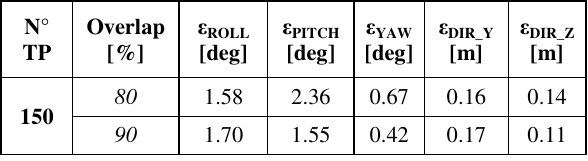
Table 12. Error propagated – 150 TP – simulation 4